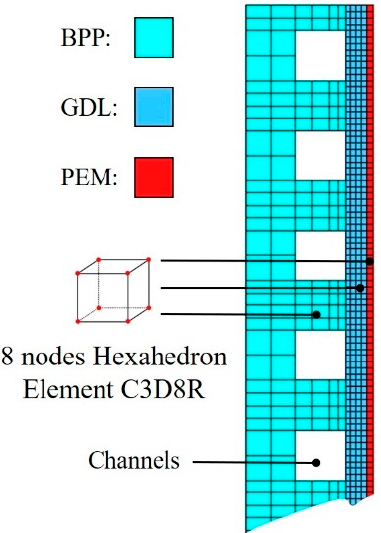
Figure 5. Locally refined meshes of the fuel cell model.